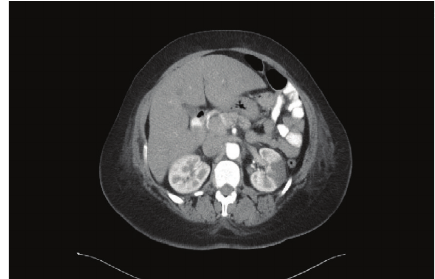
Figure 3: Echocardiographic 2 chamber view showing noncom- pacted myocardium in the left ventricle marked by yellow arrows. It also shows the ratio of noncompacted/compacted myocardium marked by red and green lines, respectively, with a ratio > 2:1. LA: left atrium, LV: left ventricle, 1–0.59 cm and 2–2.14 cm as measured.